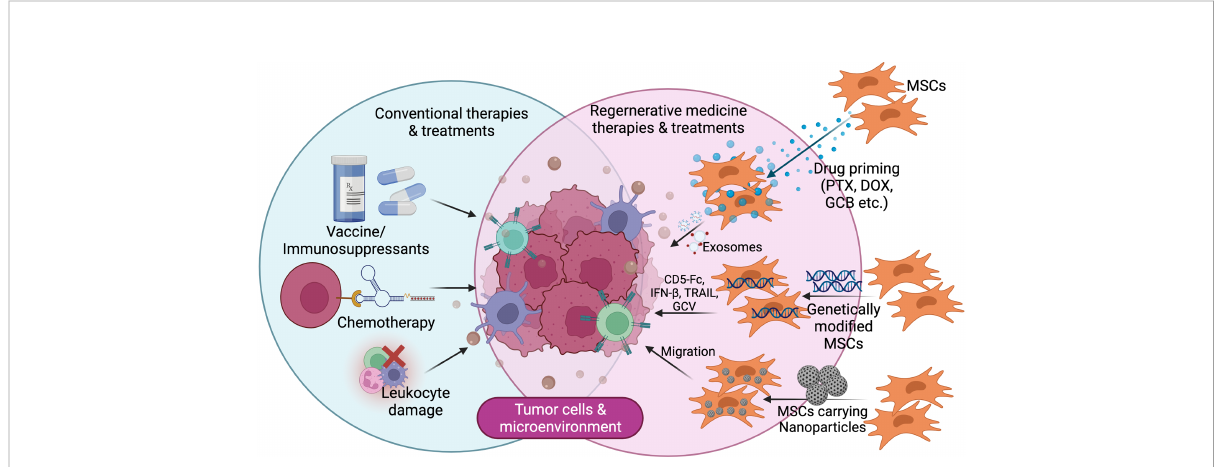
FIGURE 4 Futuristic line of cancer treatment focusing on tumor microenvironment with/using modi fi ed mesenchymal stem